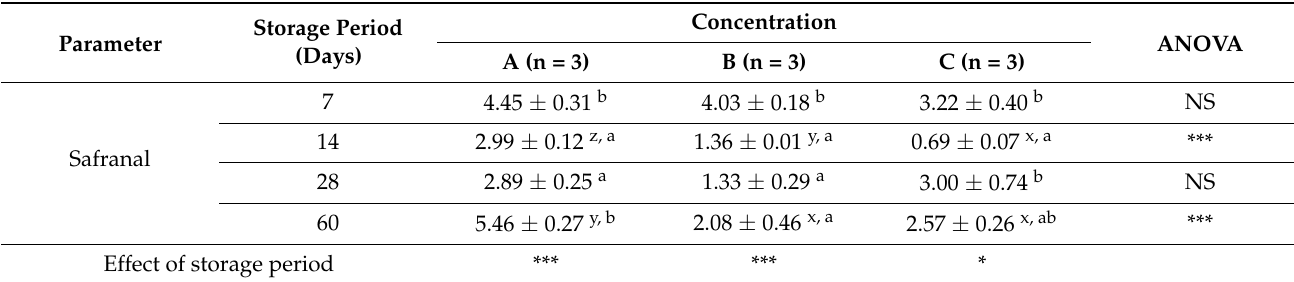
Table 3. Determination of safranal ( µ g/ 100 g ham; means ± s.e.) in sachets of sliced dry-cured ham during the storage period.